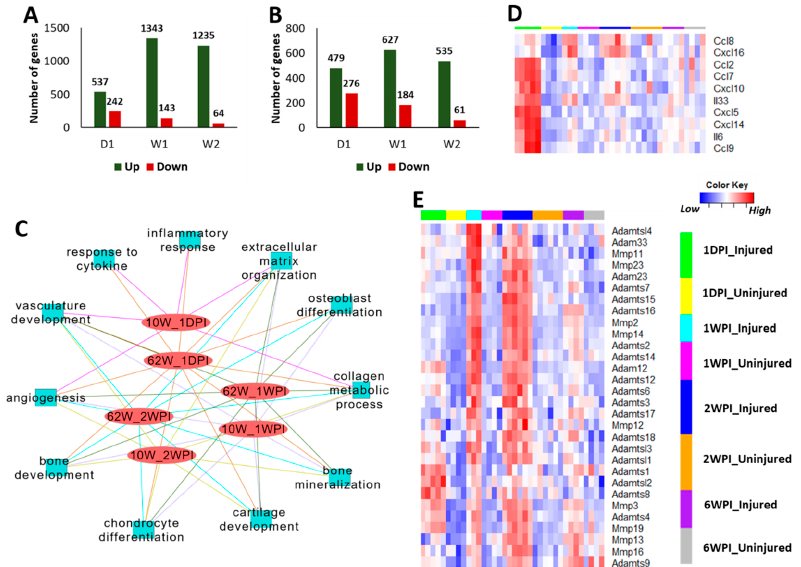
Figure 4. Injury-induced transcriptional changes at early post-injury timepoints. Number of genes up- and down-regulated in injured knee joints of 62-week-old ( A ) and 10-week-old ( B ) mice at one-day (1D), one-week (1W), and two weeks (2W) post-injury compared with uninjured contralateral joints. ( C ) Key biological processes associated with genes up-regulated in 62-week-old mice and 10-week-old mice at early timepoints. ( D ) Inflammatory cytokines up-regulated at one-day post-injury in 62-week-old mice. ( E ) Matrix degrading enzymes up-regulated in 62-week-old mice after injury. Majority of these had highest expression at 1–2 weeks post-injury. 10W: 10-week-old; 62W: 62-week-old; 1DPI: one-day post-injury; 1WPI: one-week post-injury; 2WPI: two weeks